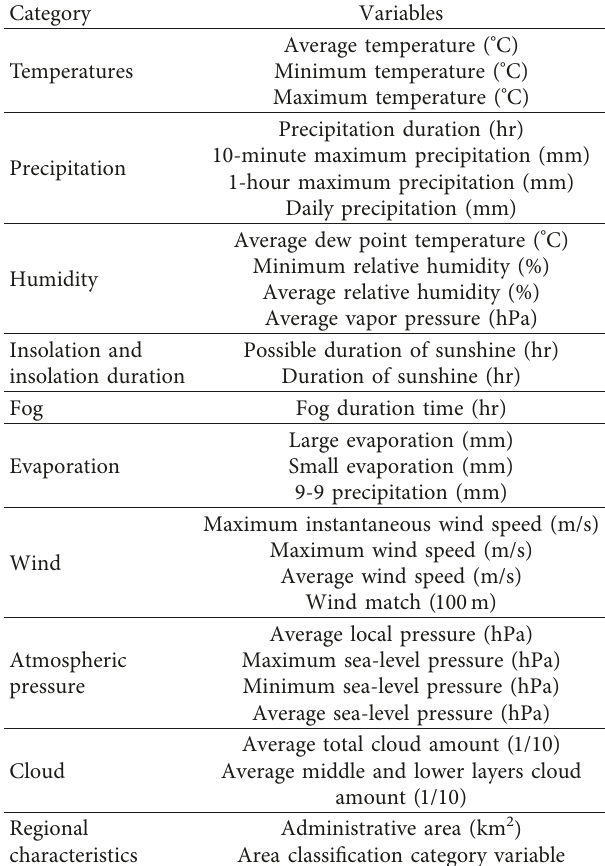
Table 2: List of explanatory variables.